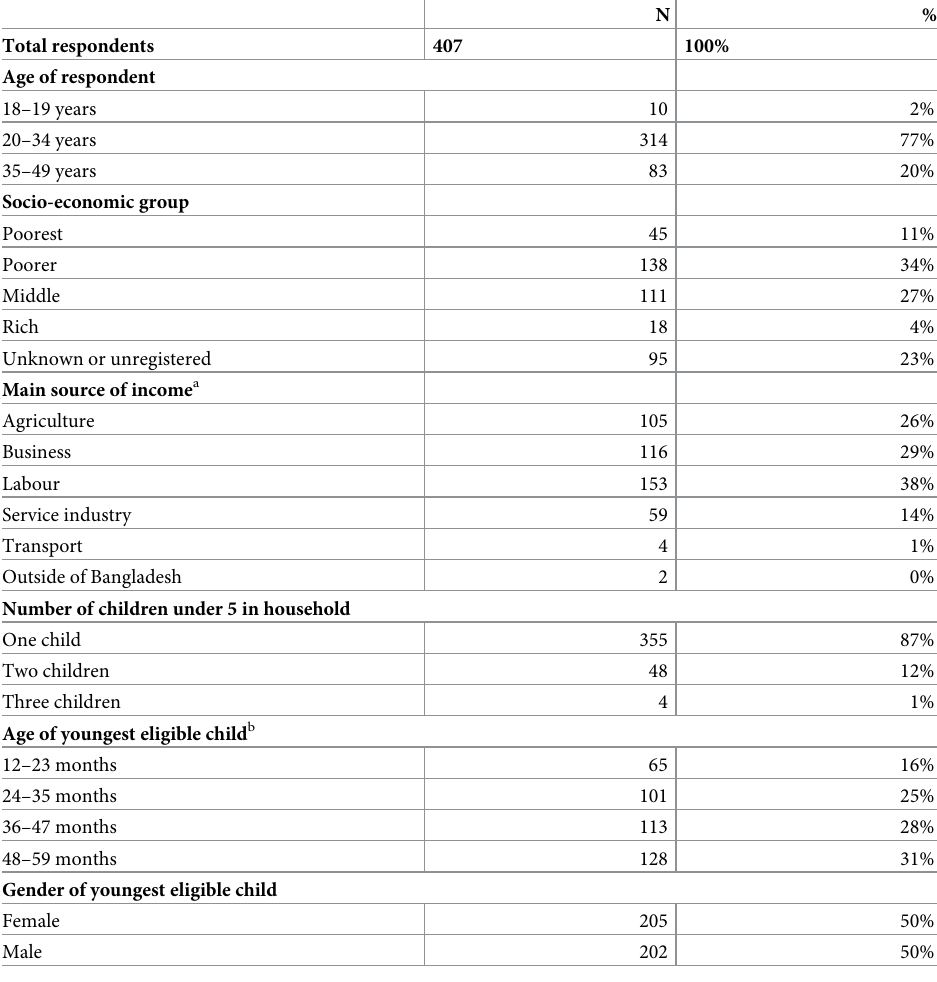
Table 2. Characteristics of study